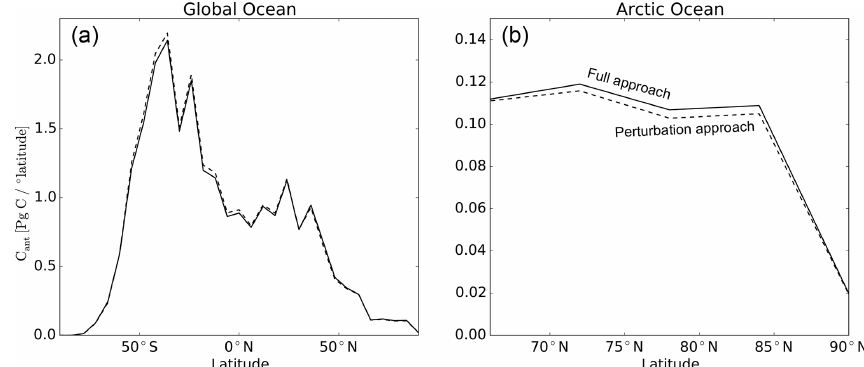
Figure A2. Zonal integral of vertically integrated C ant per degree of latitude in 2012 for the global ocean (a) and the Arctic Ocean (b) using the full biogeochemical approach (B1870-ORCA2 ∗ ) (solid) and the perturbation approach (P1870-ORCA2 ∗ ) (dashed)